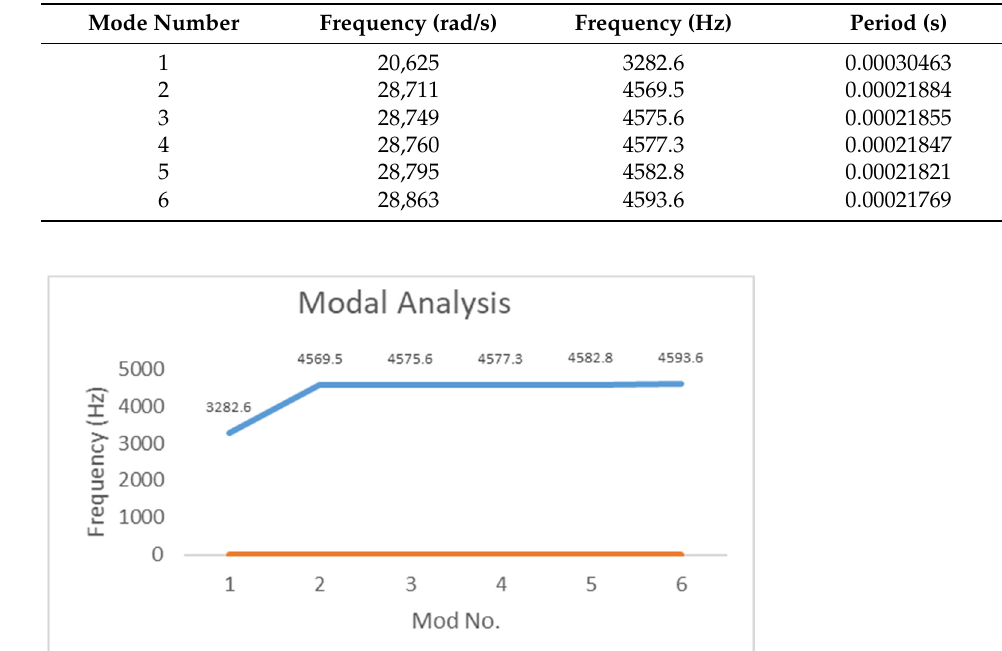
Figure 4. ( a ) Finite element analysis workflow; ( b ) Data visualization and Augmented Reality workflow. Table 1. Natural frequencies for the aluminum impeller.